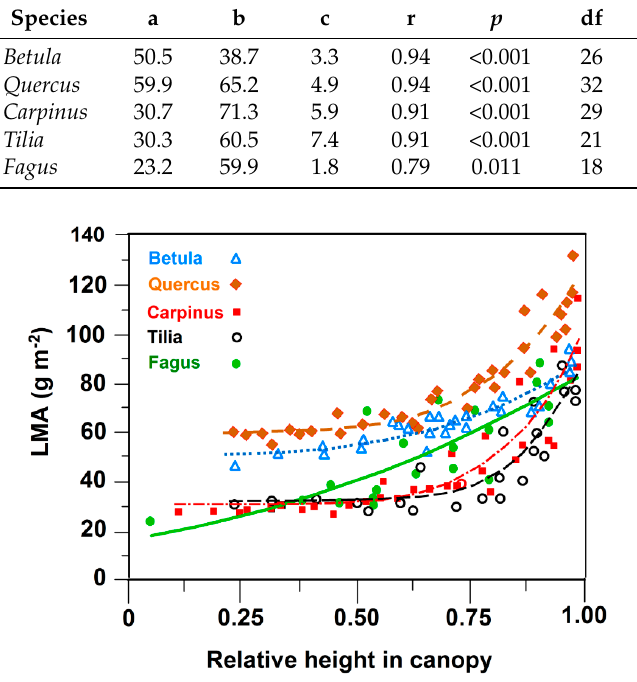
Figure 2. LMA in dependence on height in the canopy of the five tree species. Given are means of each five datasets with 25 leaves each taken per height level and tree (n = 4–11 trees per species).